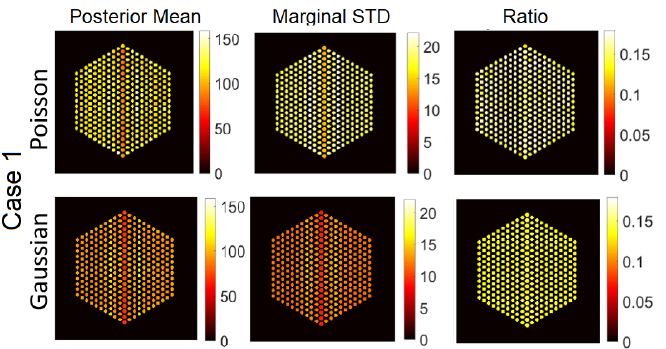
Figure 11. The IDEAL response matrix: Pin pixels averaging of the proposed approach for Case “1”. ( Left-hand column ): posterior mean, ( middle column ): marginal standard deviation, and ( right-hand column ): the ratio of marginal standard deviation divided by posterior mean.